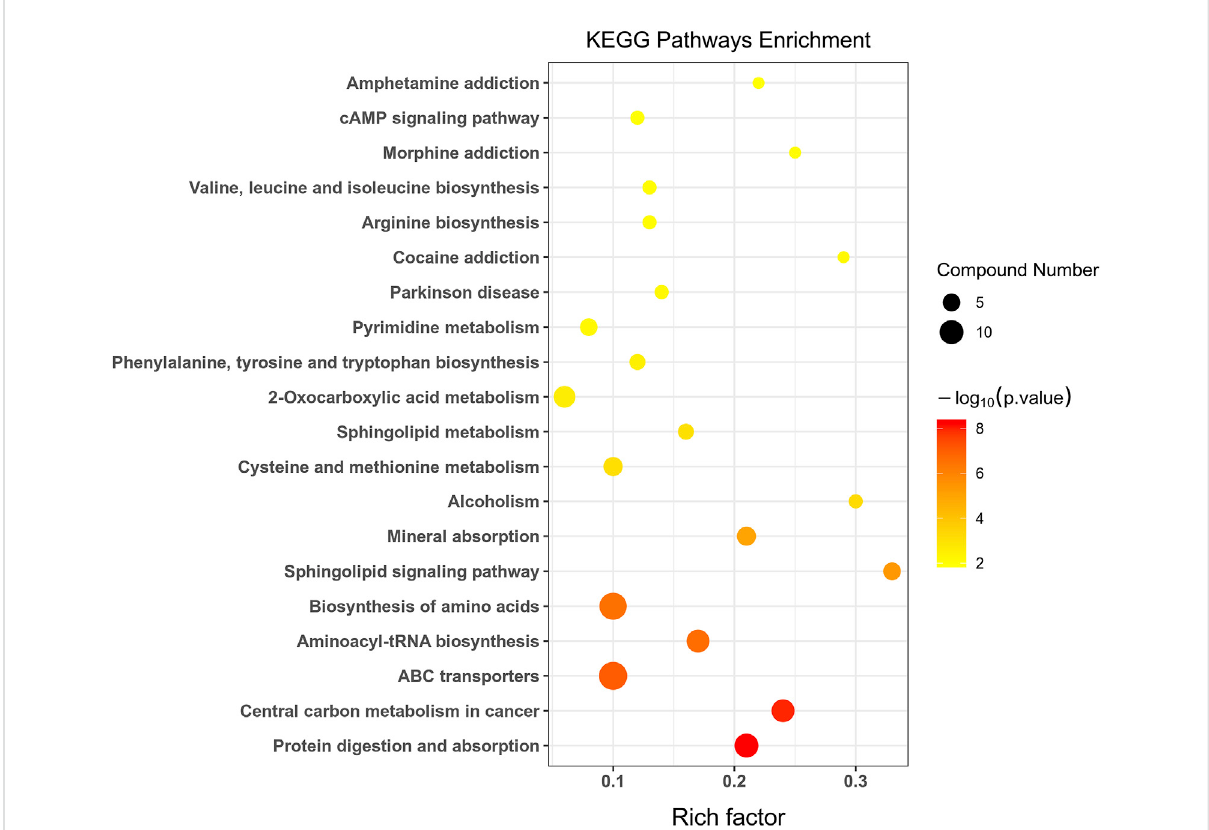
FIGURE 6 Statistics of KEGG enrichment. The x axis indicates the rich factor corresponding to each pathway, and the y axis indicates name of the KEGG metabolic pathway. The size and color of bubbles represent the number and degree of enrichment of different metabolites, respectively.